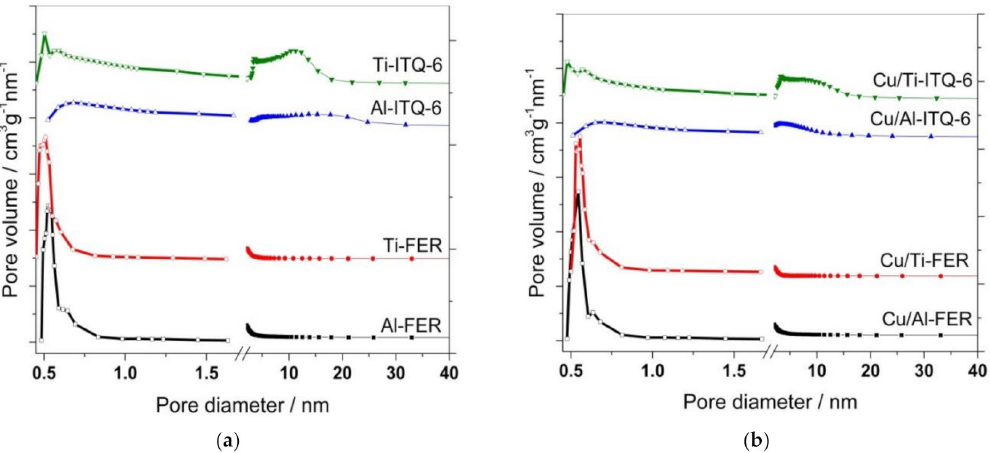
Figure 3. Pore size distributions determined for Al-, Ti-zeolites in micropore and mesopore range ( a ) and their Cu-modified forms ( b